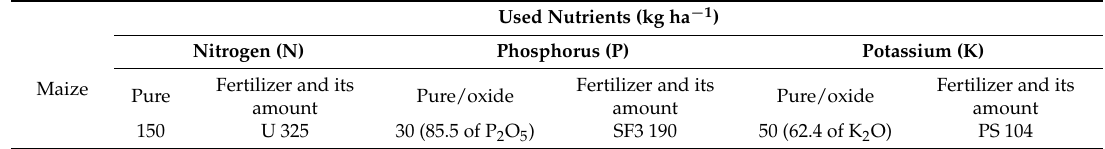
Table 7. Methodology of fertilization of